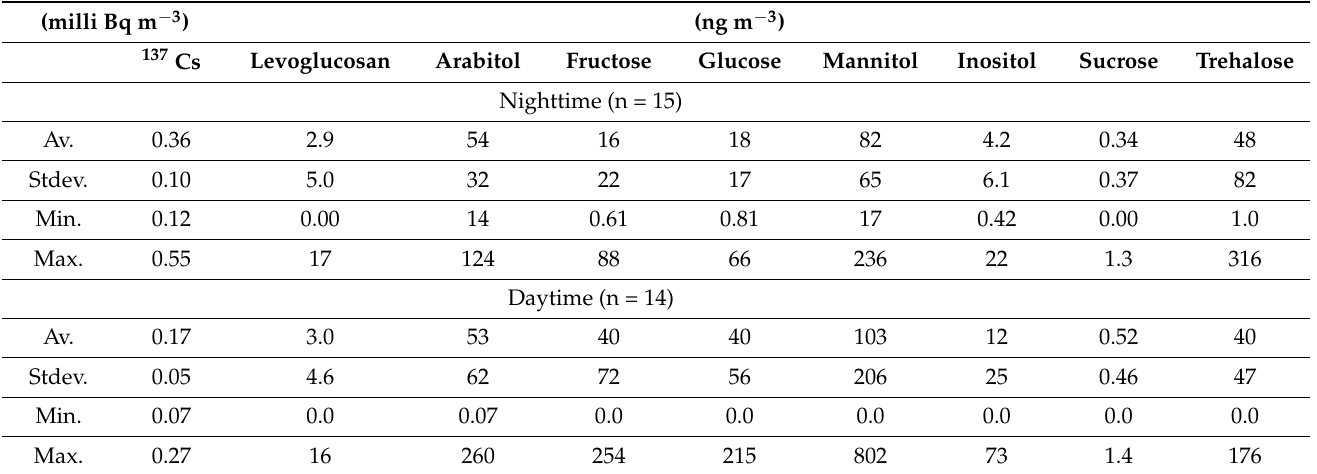
Table 1. Summary of concentrations of 137 Cs and sugar compounds in Fukushima aerosols (August to October,